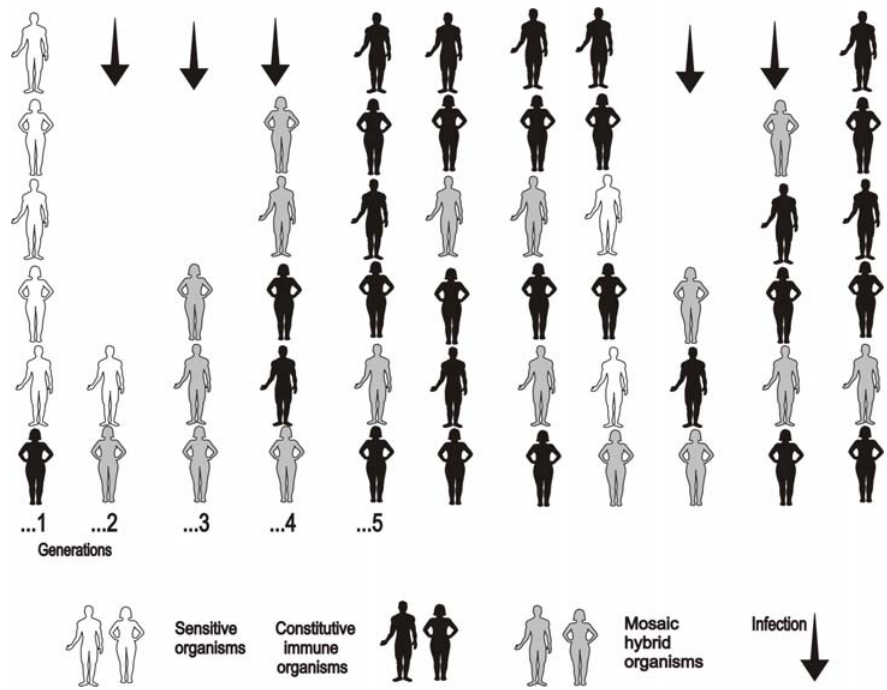
FIGURE 6 . Evolutionary transformation of immune status of a population in the fight against